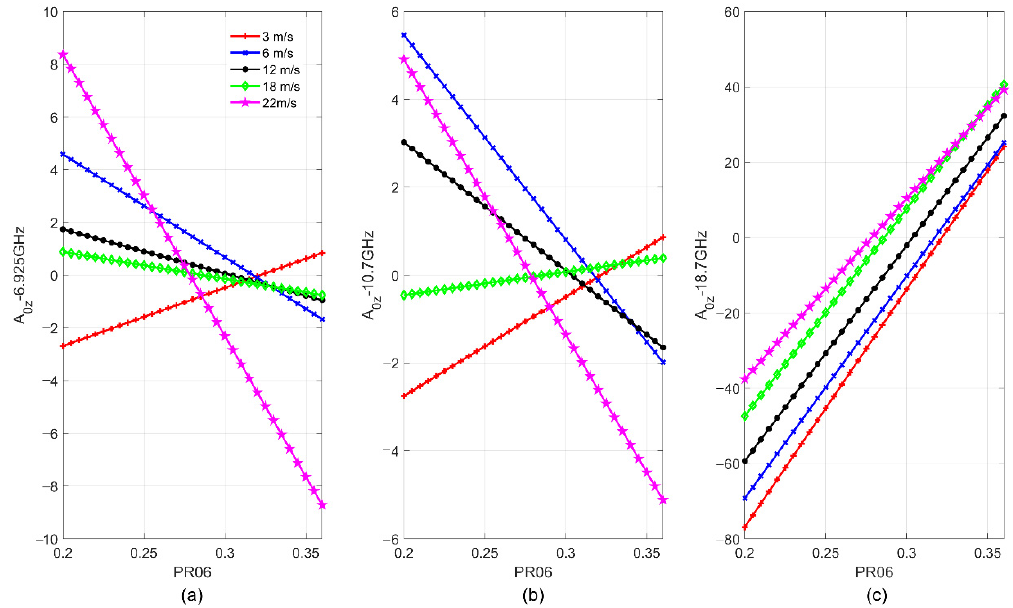
Figure 9. The coefficient A 0z varying with PR06 for wind speeds at 3 m/s, 6 m/s, 12 m/s, 18 m/s, 22 m/s, respectively: ( a ) 6.925 GHz, ( b ) 10.7 GHz, ( c ) 18.7 GHz.